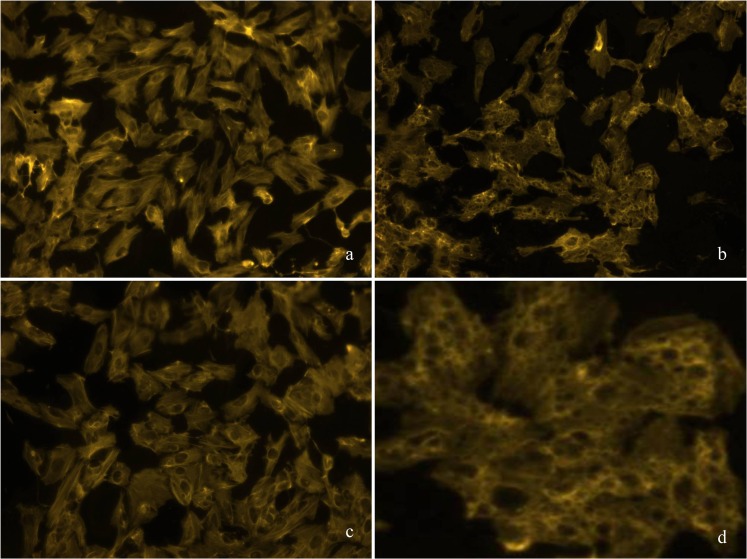
a-d. MA leads to vacuole formation in hPTECs.Staining of actin revealed intensive vacuole formation in MA-loaded (21 mM) hPTECs that could be prevented by co-incubation with rescuing amino acids. Exemplarily results for amino acid L-glutamate are shown.